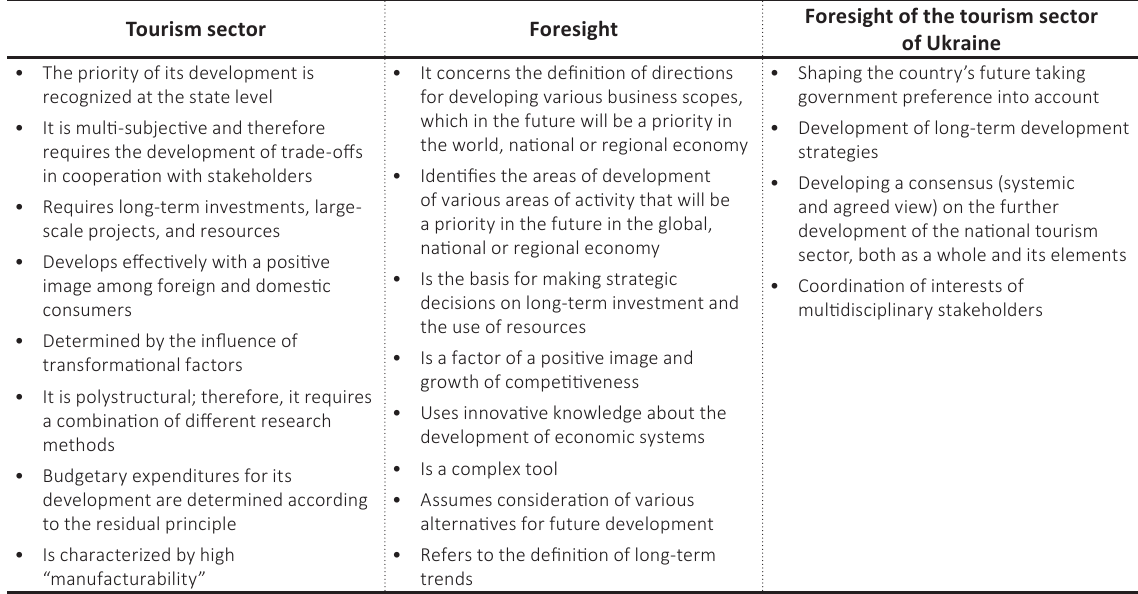
Table 1. Foresight potential for determining the strategic landmarks of the Ukrainian tourism sector Source: Improved by the authors based on Mazaraki et al.